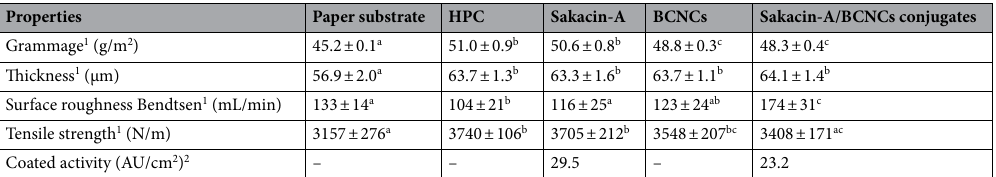
Table 2. Properties of the coated paper samples. Samples marked with the same superscript letter are not significantly different ( p < 0.05). 1 Number of measured samples: grammage, 4; thickness, 20; surface roughness, 20; tensile strength, 8. 2 Coated activities were calculated from the grammage considering the dry weight and the activity content of the coating